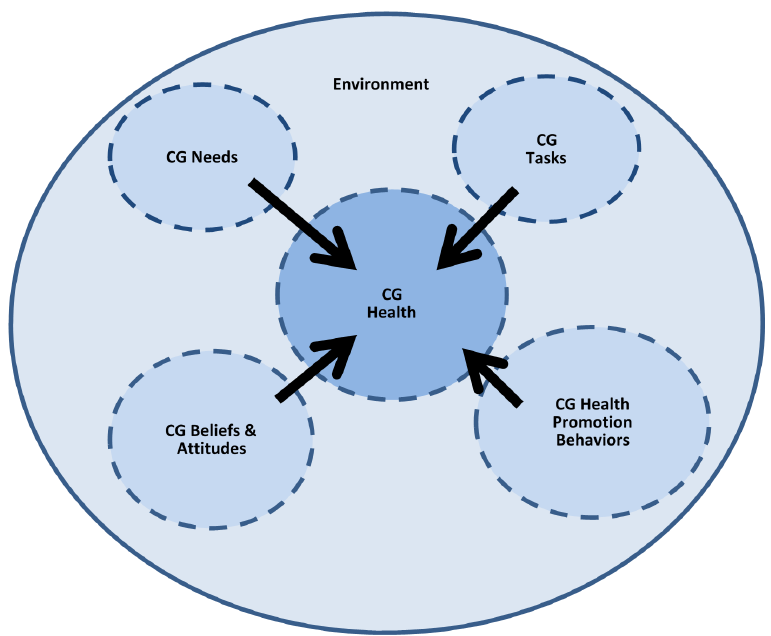
Figure 1. Caregiver health model (CGHM).